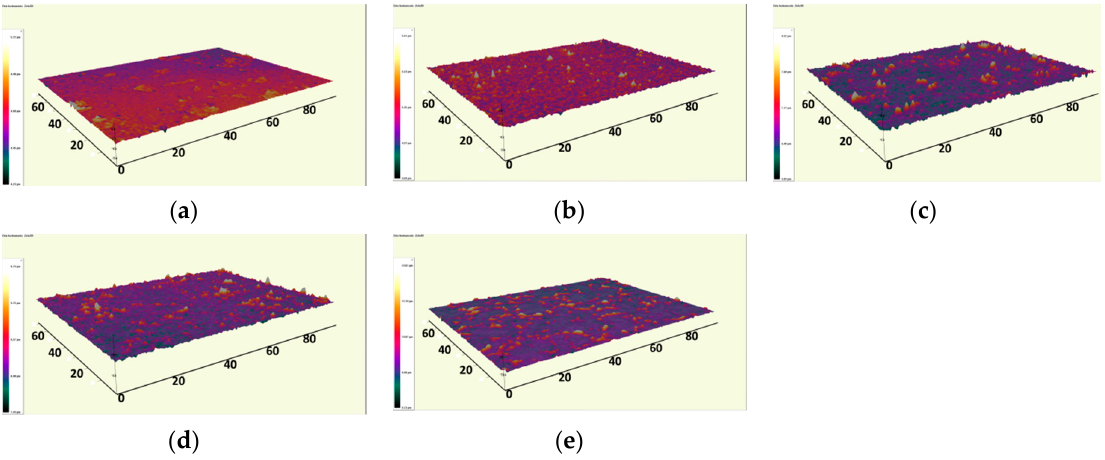
Figure 3. 3D images of electrochemical ZnO layers, deposited with different concentrations of Al 2 (SO 4 ) 3 : ( a ) 0 M; ( b ) 1 × 10 − 5 M; ( c ) 2 × 10 − 5 M; ( d ) 3×10 − 5 M; and ( e ) 4 × 10 − 5 M.